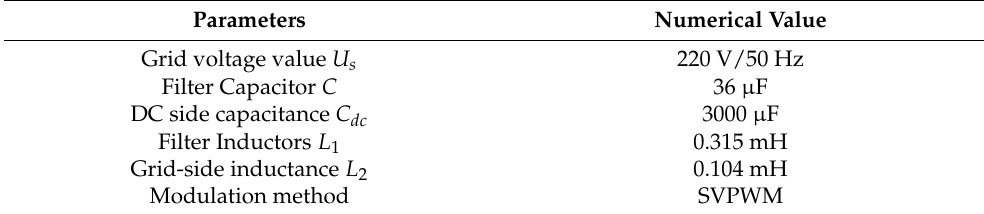
Figure 9. Single-phase PAPF simulation model. Table 2. System simulation parameters.